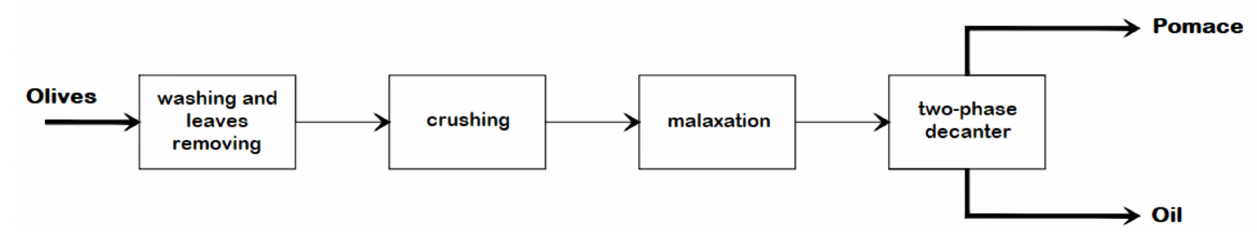
Figure 4. Typical stages of VO or EVOO production